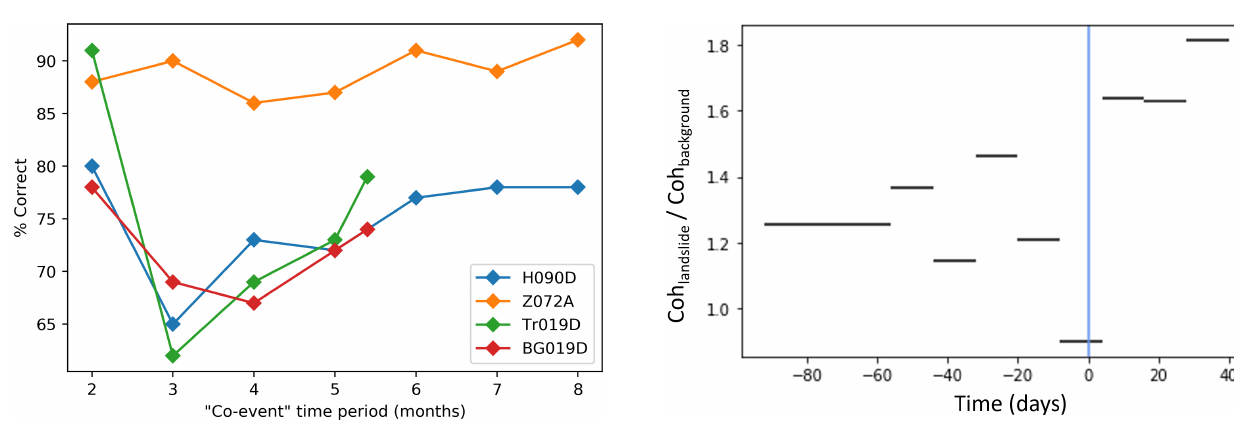
Figure 7. The percentage of landslide timings that are correct when assigned by (cid:62) two of the techniques described in Sect. 2.4 for a range of co-event time periods.